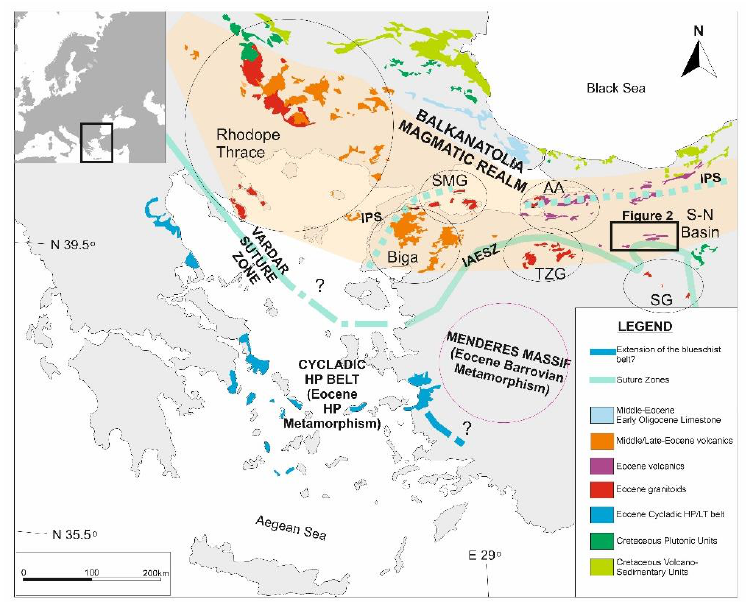
Figure 1. Geological sketch map showing the distribution of Late Mesozoic to Early Cenozoic units around Greece and Western Anatolia. The data to generate the map were compiled from [2,4,5,22,23,32 – 34]. IPS: Intra- Pontides Suture, IAESZ: İzmir– Ankara – Erzincan Suture Zone, SMG: